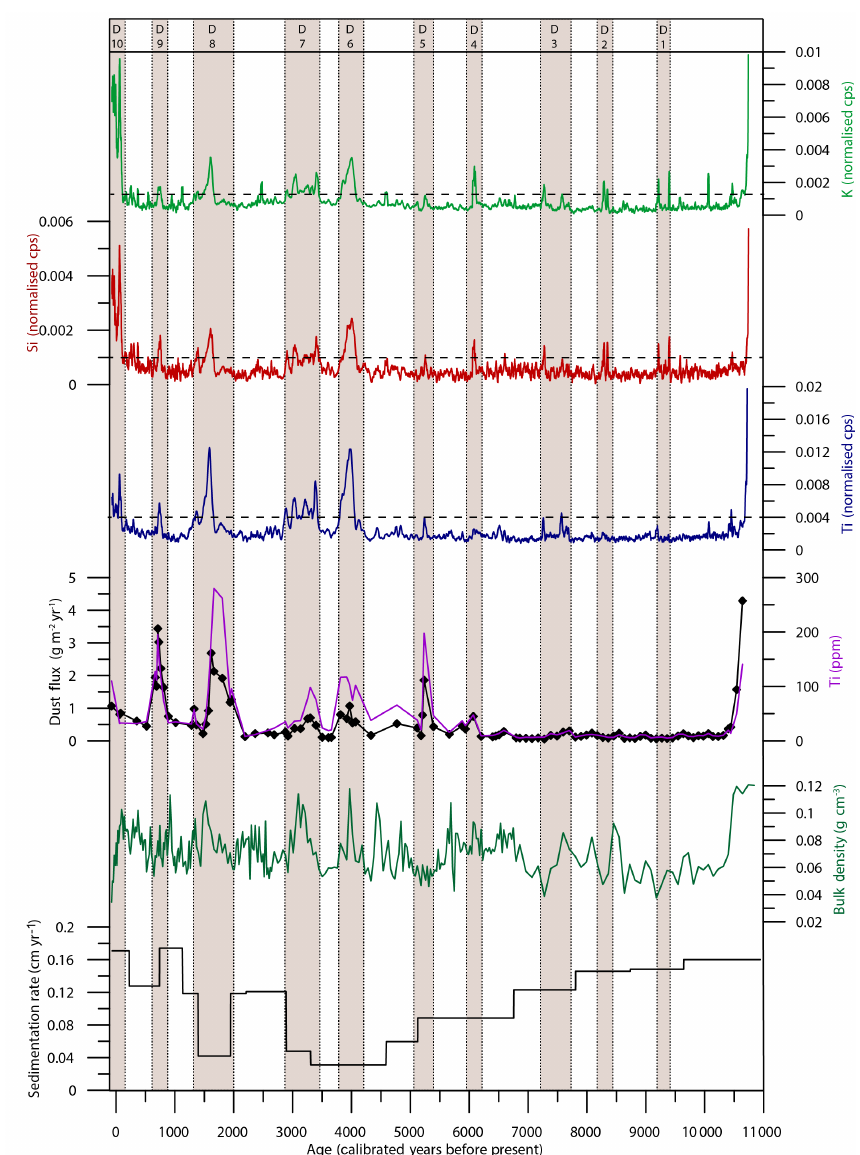
Figure 3. Itrax data of lithogenic element (K, Si, and Ti) concentration throughout the Mohos peat record, with all data smoothed using a nine-point moving average to eliminate noise. Furthermore, dust flux as reconstructed from Ti concentration values (also displayed) and sedimentation rate is presented. Dust events (D0–D10), as identified from increases in at least two of the lithogenic elements under discussion, are highlighted in brown and labelled. Dashed lines on Itrax data indicate the enrichment above which a dust event is denoted.